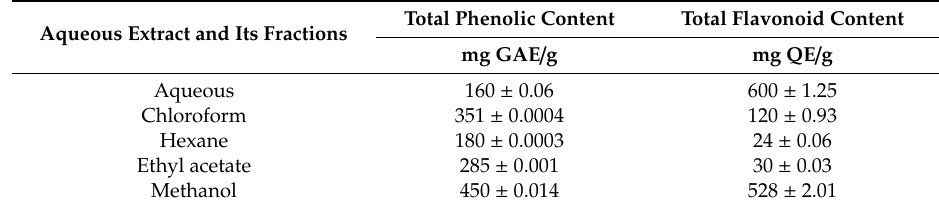
Table 1. Total phenolic and flavonoid contents of the crude aqueous extract and di ff erent fractions of Nyctanthes abor-tristis flowers.